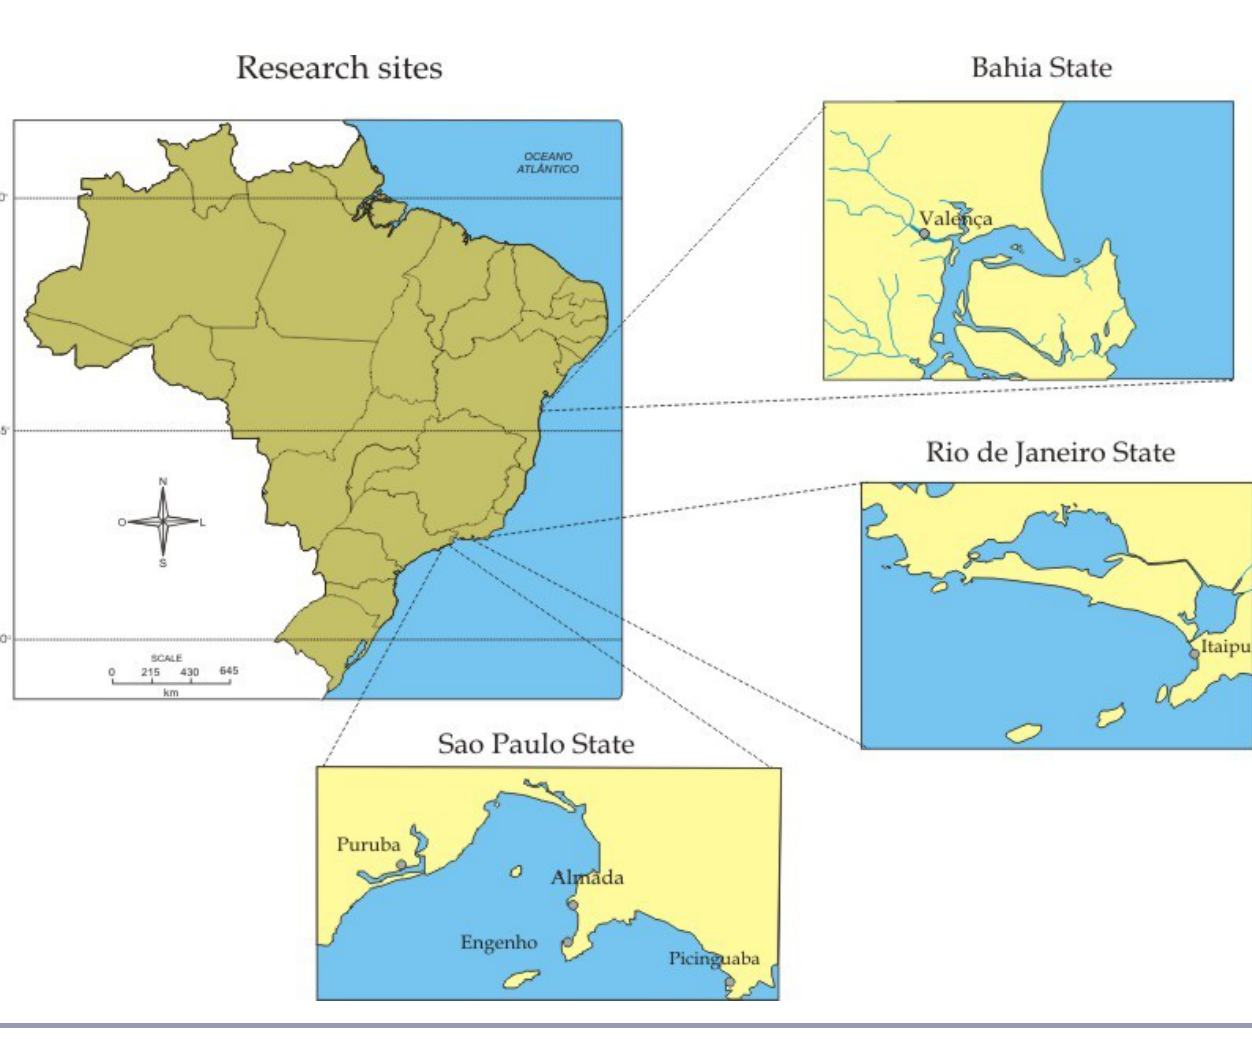
Fig. 1 . Research sites in Bahia, Rio de Janeiro, and São Paulo States,